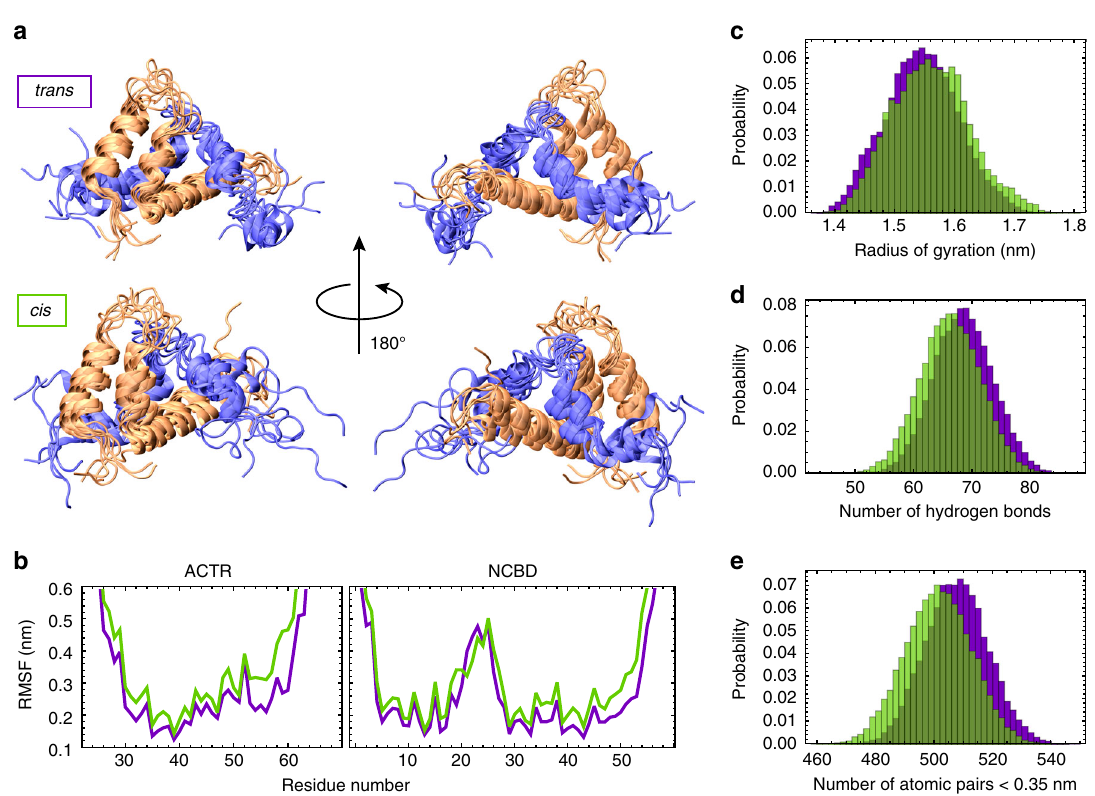
Fig. 4 Effect of Pro20 isomerization from replica exchange MD simulations. a Overlap of representative conformations of the NCBD (orange)-ACTR (blue) complex with Pro20 in the trans and cis state. b Root mean square fl uctuation (RMSF) pro fi les along the sequence of ACTR and NCBD, with NCBD Pro20 in trans (purple) or cis (green). The RMSF was averaged over all atoms of each residue. c Probability distributions for the radii of gyration of the NCBD-ACTR complex, with NCBD Pro20 in trans (purple) or cis (green). d , e Probability distributions of intermolecular hydrogen bonds ( d ) or any intermolecular atomic pair falling within a 0.35-nm distance cutoff ( e ) in the MD simulations with Pro20 in trans (purple) or cis (green)